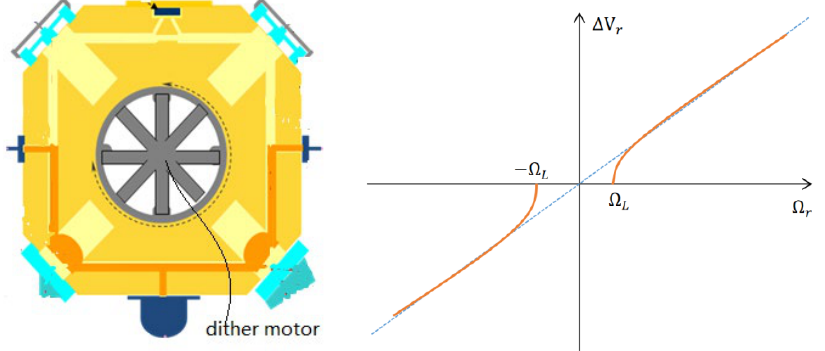
Figure 1. Laser gyro and its lock-in effect.